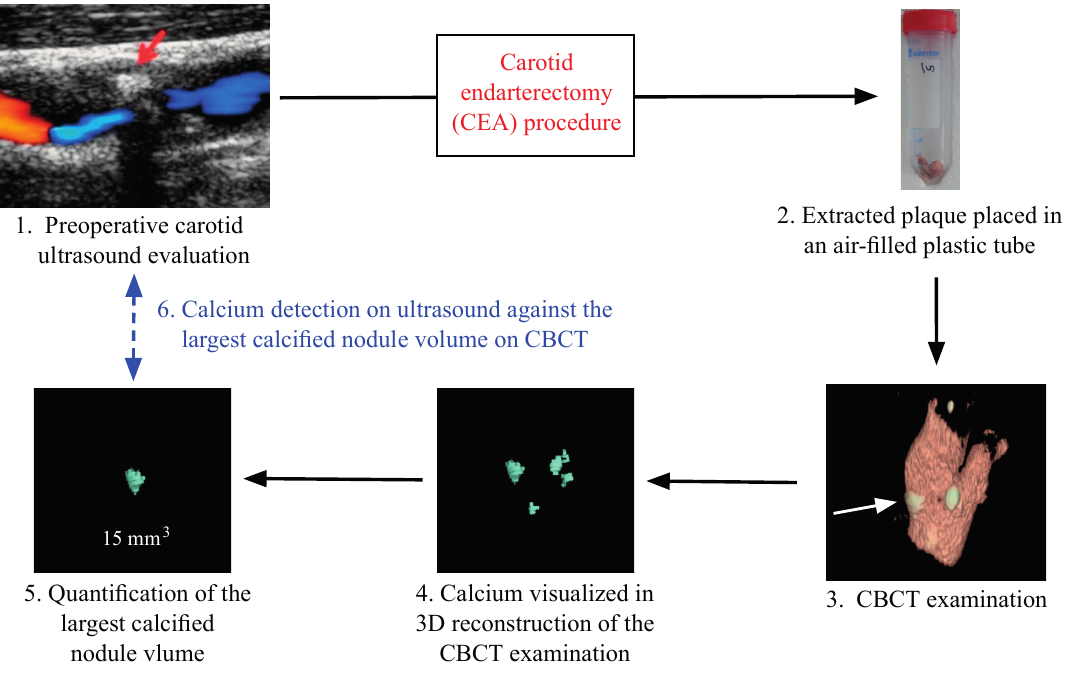
Figure 2. Flowchart of the work process of the study, starting with preoperative ultrasound examination, Cone Beam Computed Tomography (CBCT) evaluation of the carotid specimens removed after carotid endarterectomy (CEA) to images reconstruction and data analysis. Red arrow: hyperechoic spot with posterior shadowing (calcification) on ultrasound. White arrow: calcification on CBCT